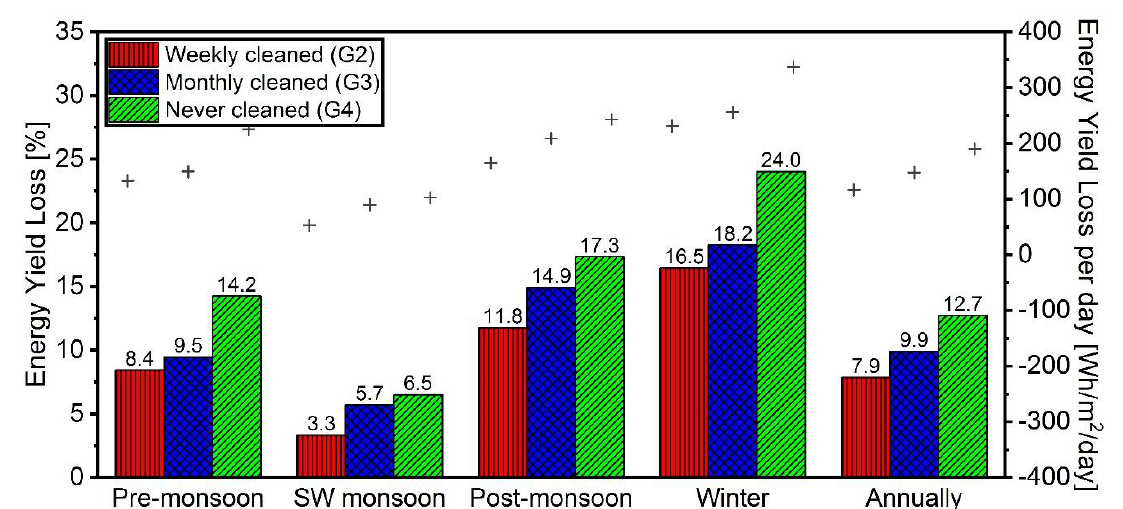
Figure 15. Energy yield loss percentage due to soiling for different cleaning cycles during the four seasons and annually at STC. The “+” symbol denotes the (predicted) energy yield loss in Wh/m 2 /day for the right side of the